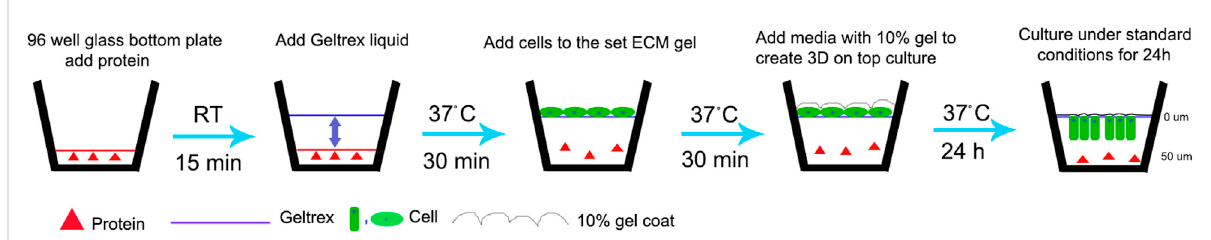
FIGURE 1 Schematicrepresentationofmodi fi ed3D-on-topculturemethod(sideview).Redtrianglerepresentsproteins-test(AMEL,AMBN,AMBN17kDa, AMBN Δ 5)andcontrol(BSA,heatdenaturedAMBN).GreenovalandrectanglerepresentHAT-7cells.Solidline-GFRGeltrexafterpolymerizationand scalloped line denotes 10% gel overlaid on cells. 0 and 50um markings are used to indicate the Z position on the surface (0 um) and within the gel (50 um) after 24 h resulting in elongation of the cells as shown in Figures 2D,E and Figure